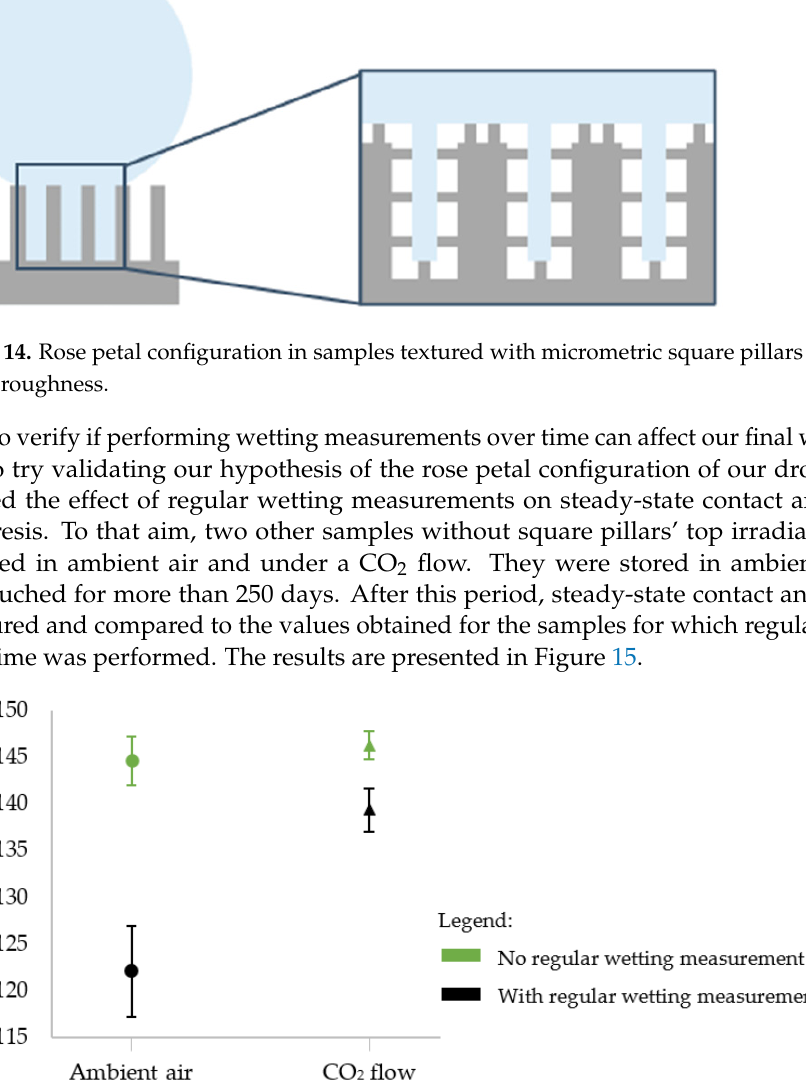
Figure 15. Steady ‐ state contact angles of samples textured in ambient air or under a CO 2 flow for which the square pillars’ top was not irradiated, and for which regular wetting measurements were (in black) or were not (in green) conducted over time.